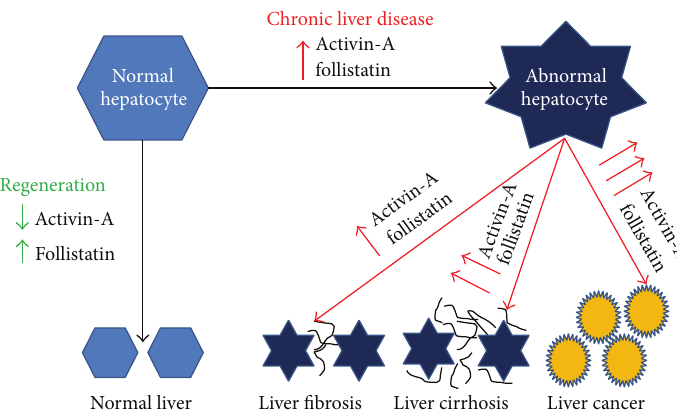
Figure 3: The production of activin-A and follistatin by normal and abnormal hepatocyte. Activin-A and follistatin regulate hepatocyte regeneration in healthy liver. Pathological increase of both activin-A and follistatin by the hepatocyte is associated with several liver diseases including fibrosis, cirrhosis, and hepatocellular